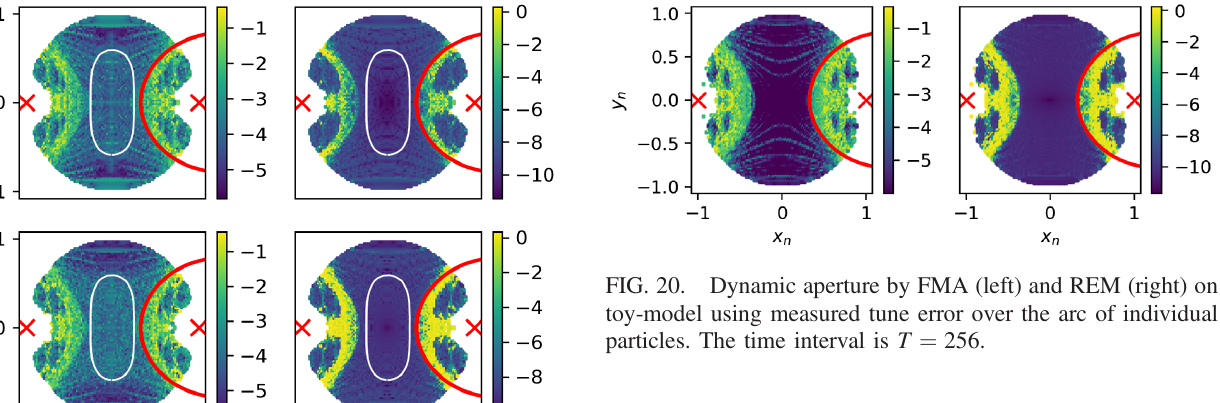
of all particles in the REM